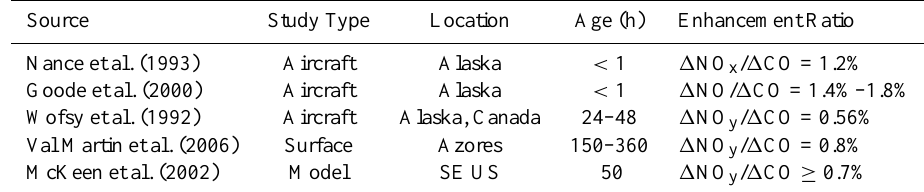
Table 1. Previous measurements of NO x and NO y enhancement ratios (mol/mol) for boreal plumes. Source